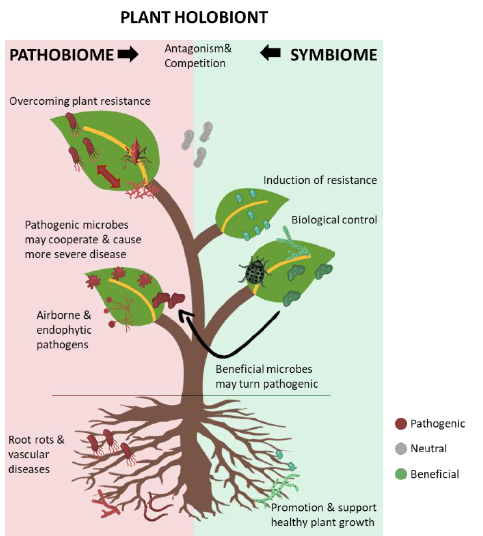
Figure 1. A schematic diagram of the plant holobiont as a complex system, including beneficial plant-associated microbes—the symbiome—and the collective pathogenic microbes—the pathobiome. The beneficial and pathogenic microbes are in continuous antagonism and competition for space and nutrients. When pathogenic microbes prevail, they interfere with normal plant functions, leading to disease development. Co-operative interactions amongst pathogenic microbes may result in more severe disease and multiple infections. The stable, beneficial plant microbiome may be altered to facilitate the development of certain diseases, as observed in the olive knot disease.